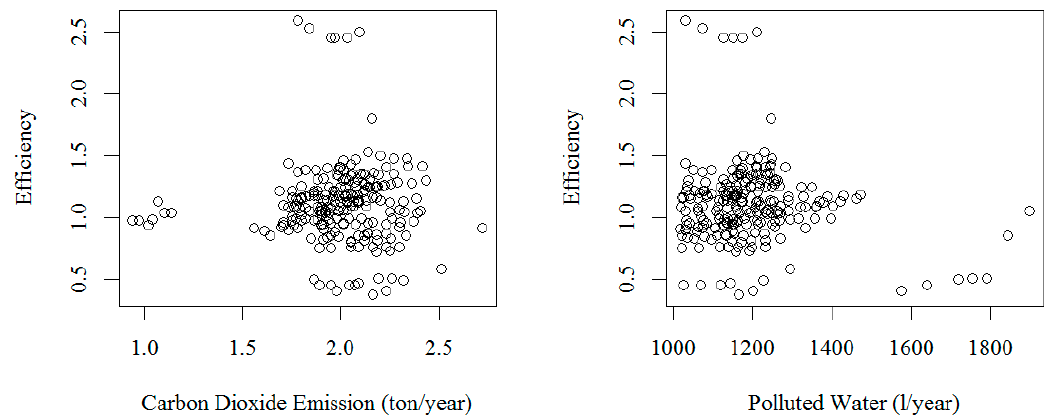
Figure 3. Scatter plots for super-efficiency levels and pollutant emissions.